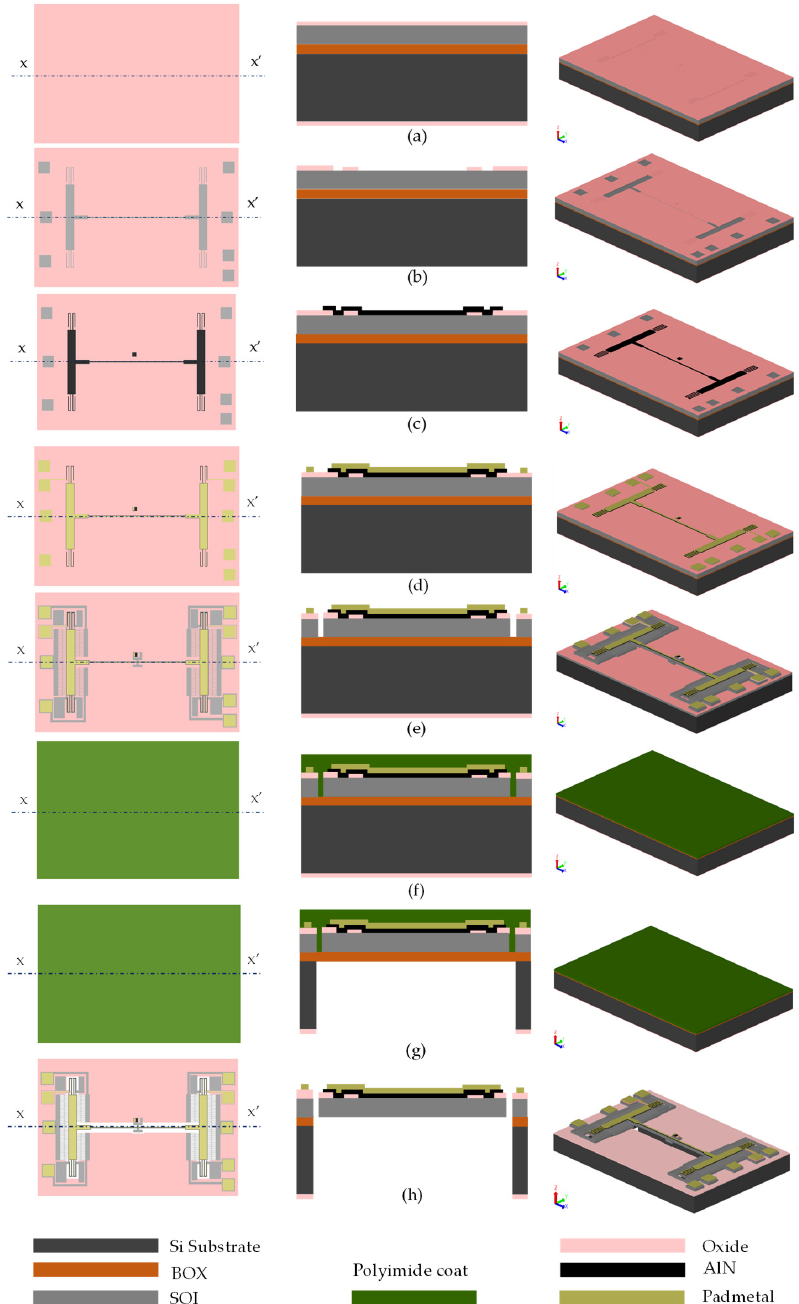
Figure 2. Fabrication steps of the piezoelectric actuator based on the PiezoMUMPs process: ( a ) the starting SOI wafer, ( b ) patterning the thermally grown oxide layer, ( c ) depositing and patterning of the AlN piezoelectric layer, ( d ) depositing and patterning the metal layer, ( e ) front-side etching of the SOI layer, ( f ), front-side protection layer using a polymer layer, ( g ) back-side etching of handle layer, and ( h ) releasing the